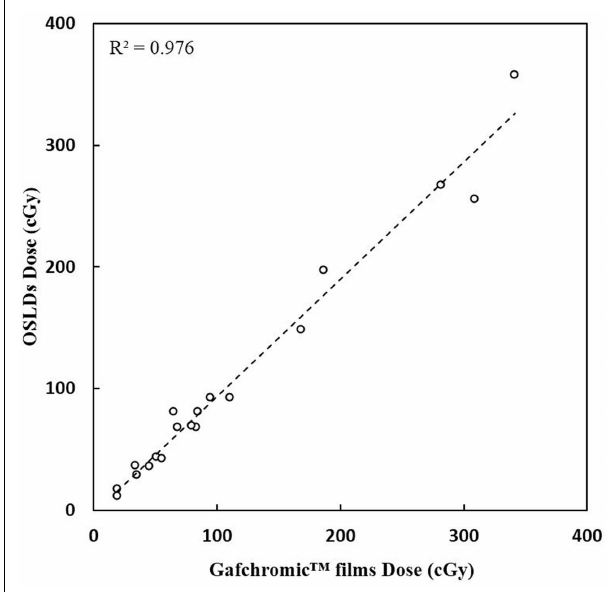
FIGURE 5 | Correlation between OSLDs and Gafchromic films measurements .